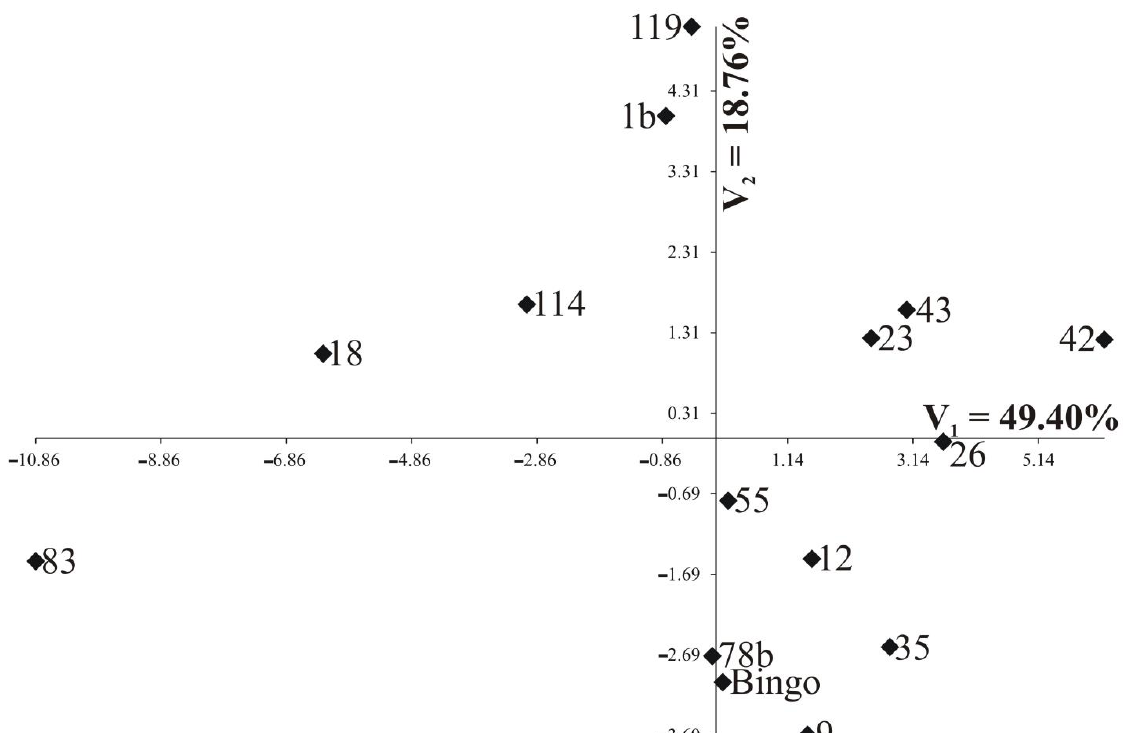
Figure 6. Distribution of 15 genotypes in the space of the first two canonical variables for drought .